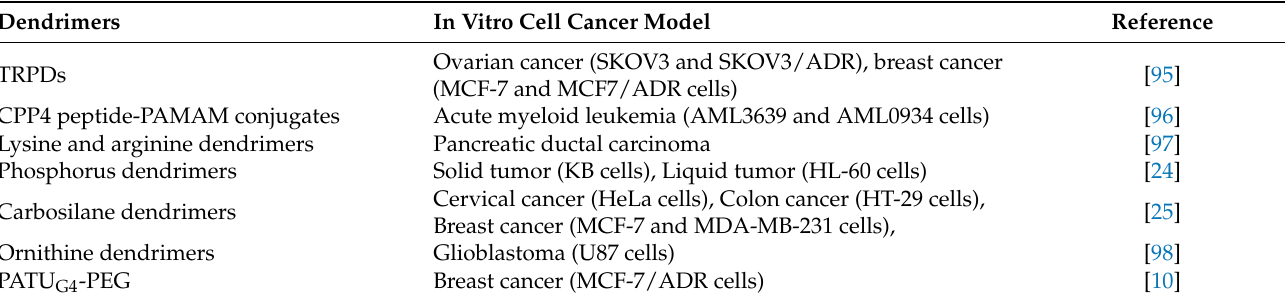
Table 5. Selected dendrimers used as anticancer